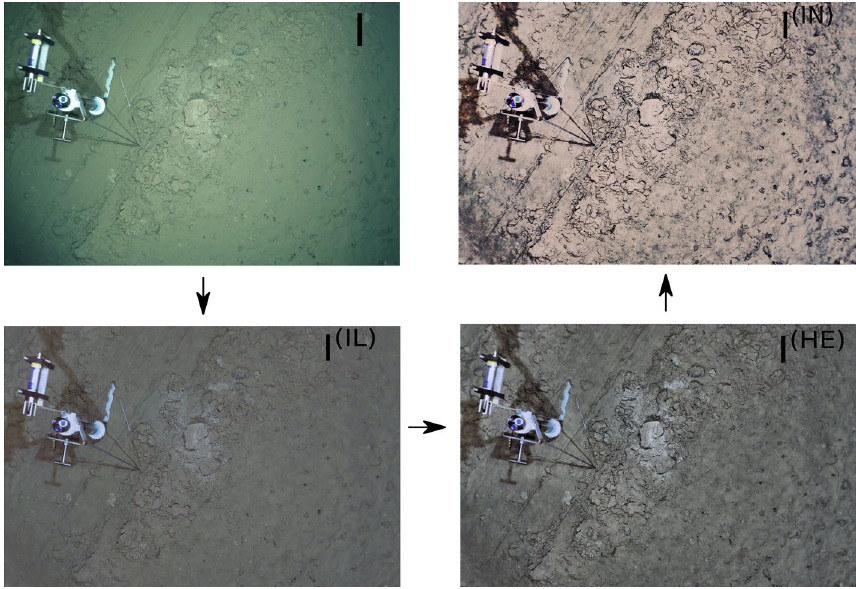
Figure 12. Example showing the color normalization transformations positioned counterclockwise. The transformation progresses from original image I to illumination drop-off corrected image I (IL) to histogram equalized image I (HE) and finally to the color normalized image I (IN)